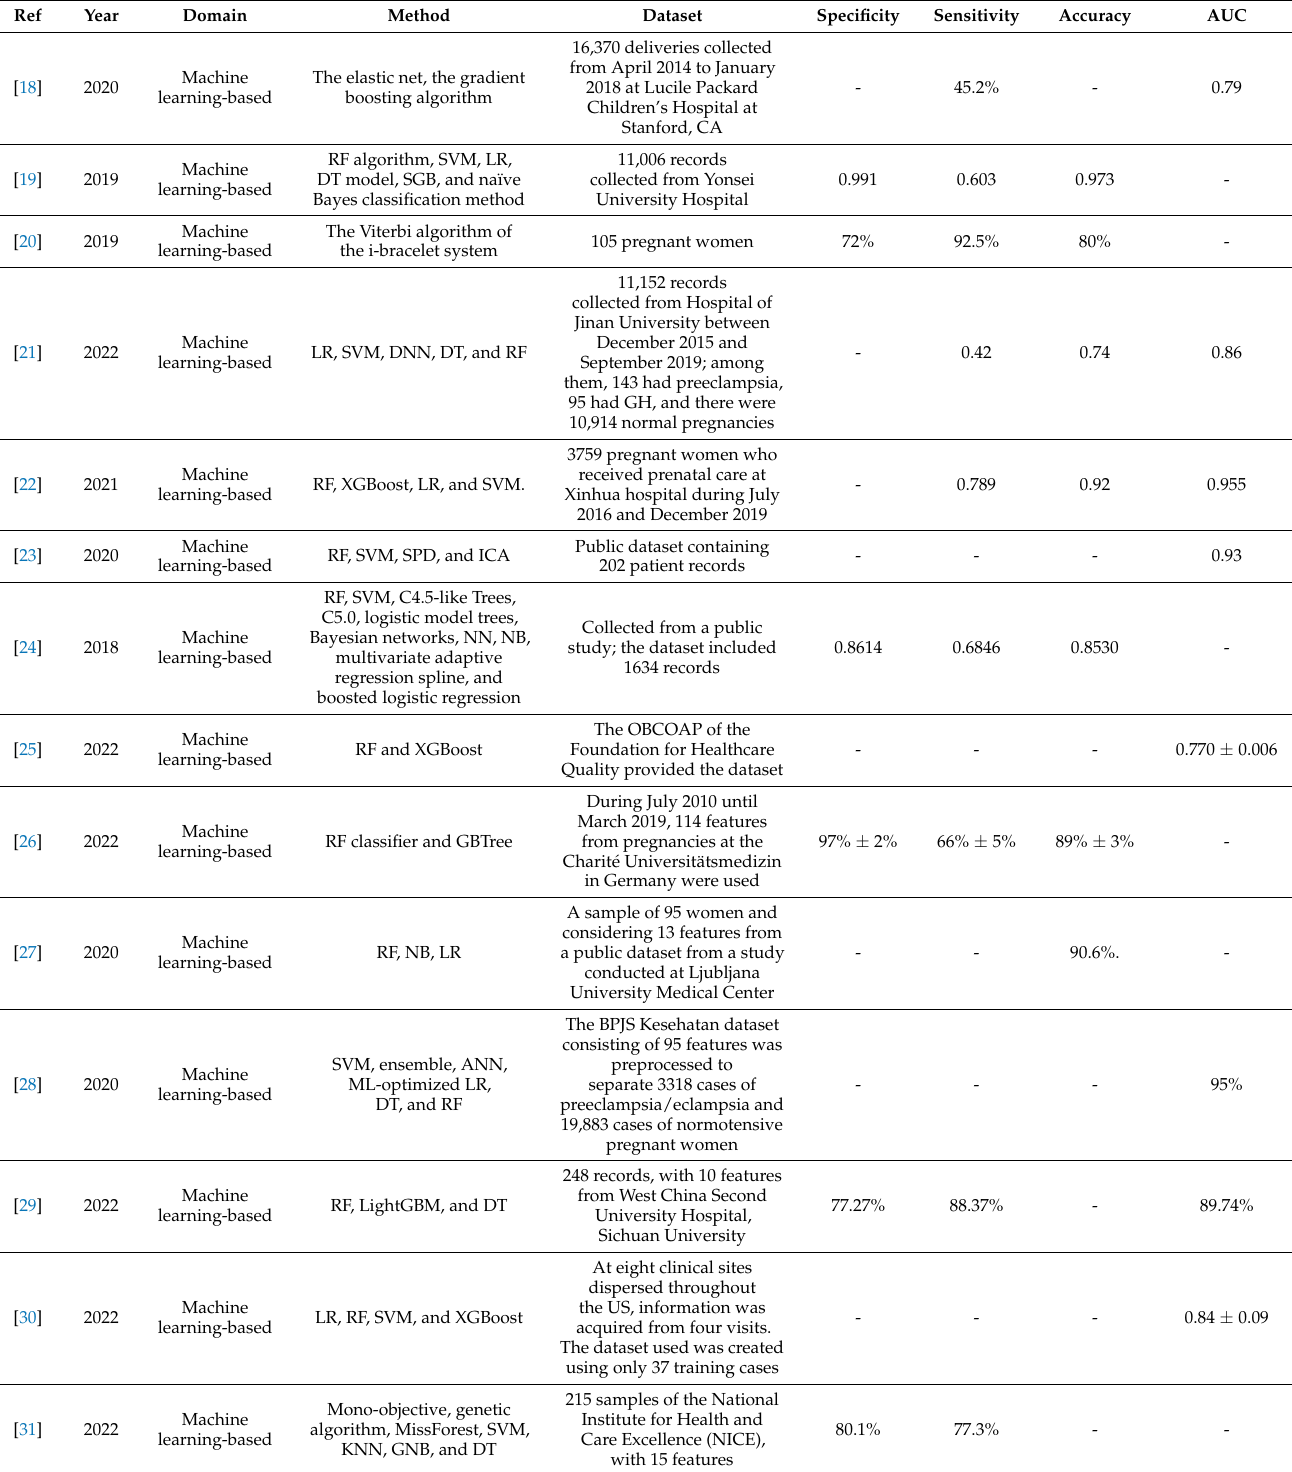
Table 2. Summary of related studies using machine